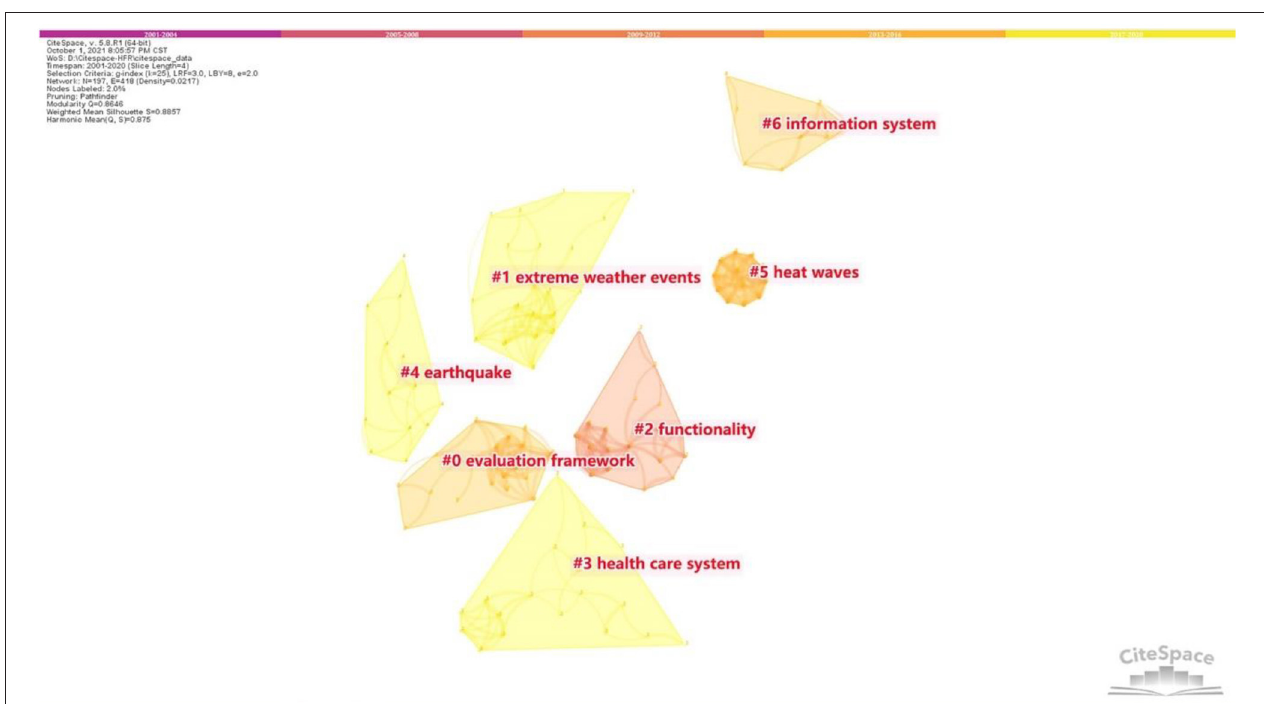
FIGURE 6 | Literature co-citation network.